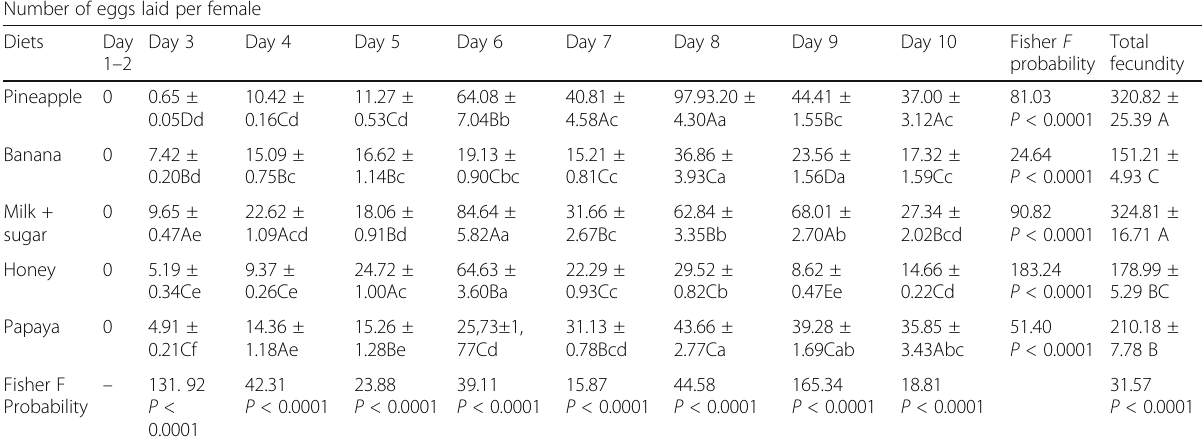
Table 2 Evolution of fecundity (means ± standard deviation) of M. domestica females according to type of food and time Number of eggs laid per female